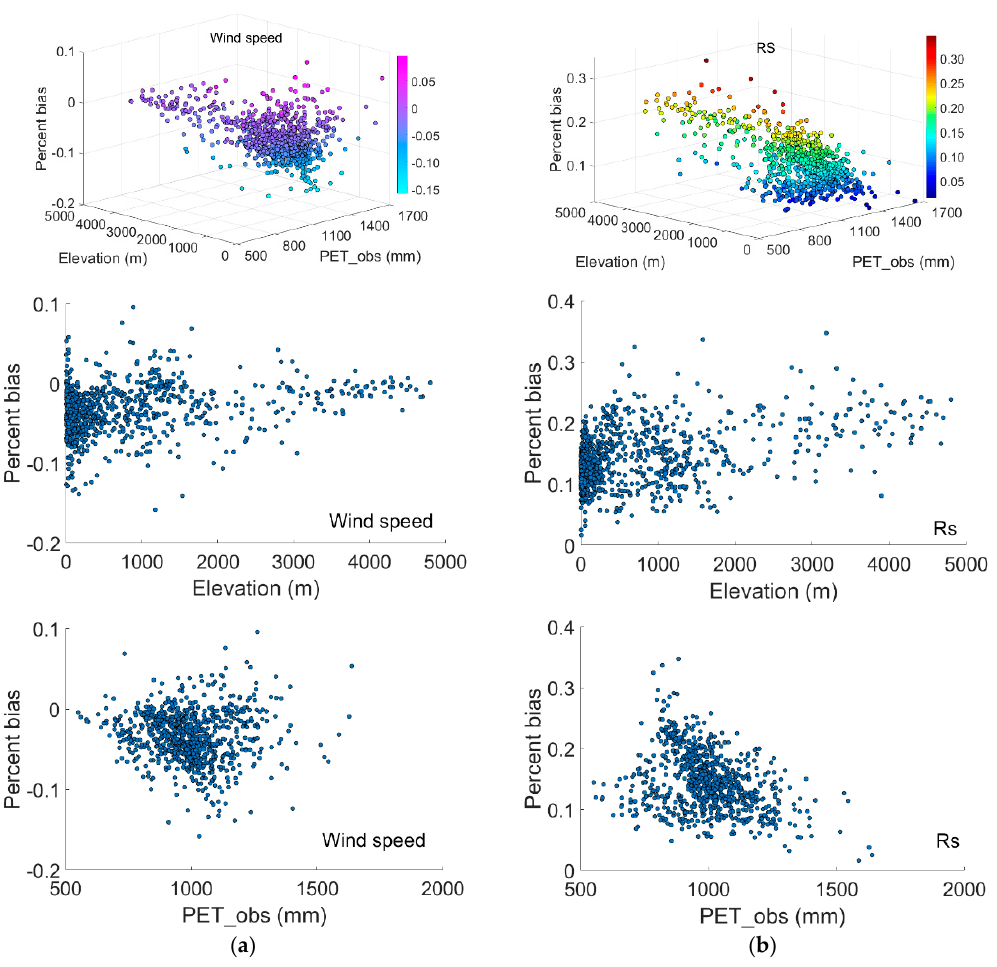
Figure 8. Relationship between elevation, PET_obs, and errors indicated by percentage bias for wind speed ( a ) and solar radiation ( b ).